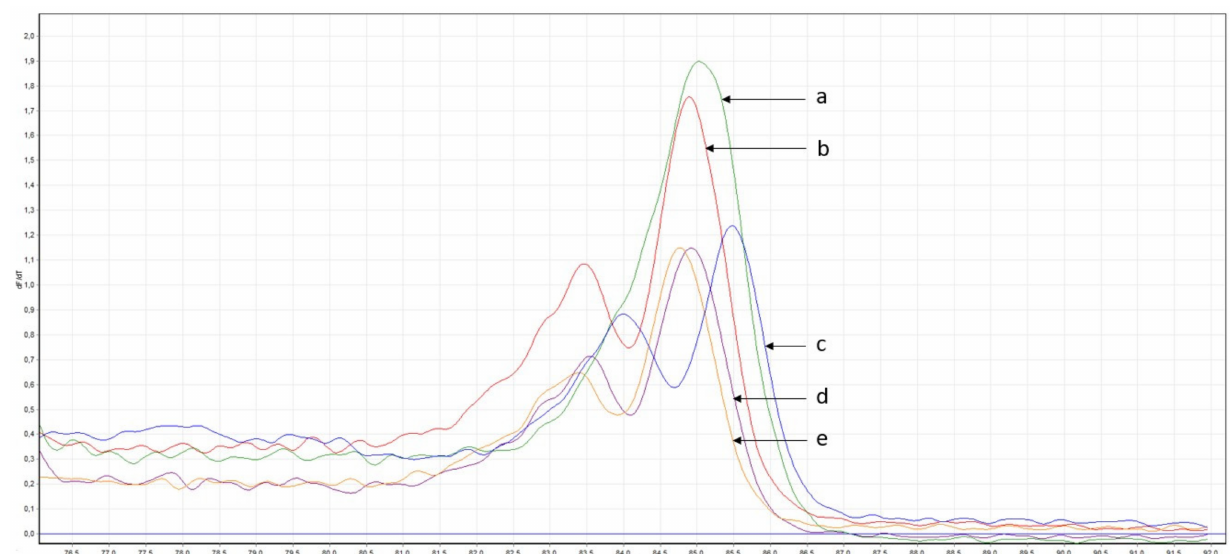
Figure 8. Derivatives of melting curves of amplicons obtained during PCR of a section of the FANCA gene. ( a ) DNA samples without changes in the nucleotide; ( b , d , e ) Example of DNA samples with difference in melting point; ( c ) DNA sample with c.G1874C (positive control).